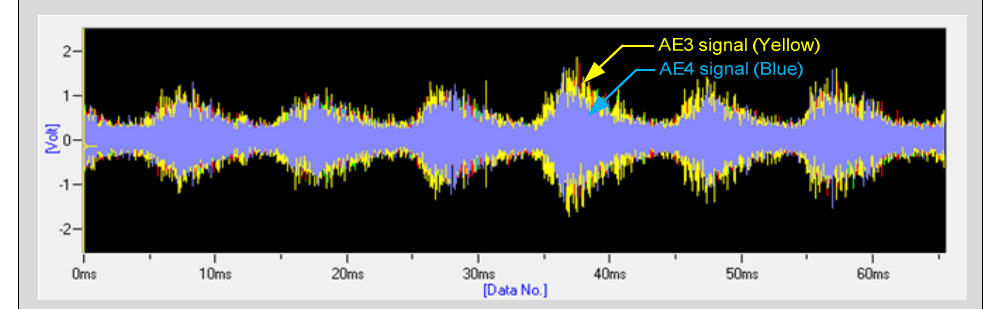
Figure 10. The comparation PD signal waveform when all AE sensor installation on housing of high side transformer. side